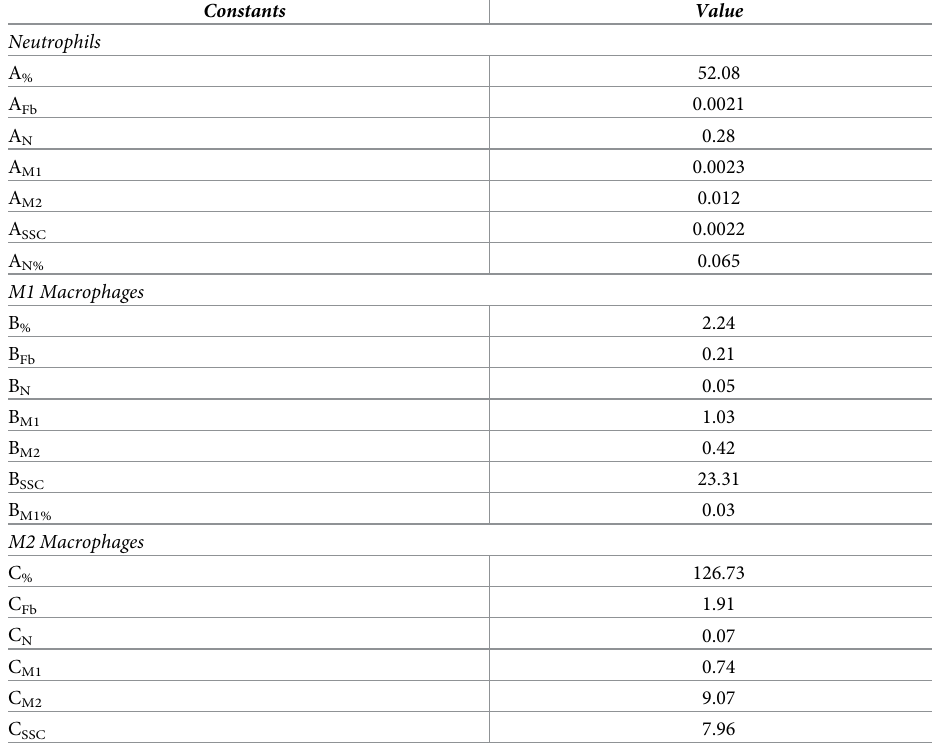
Table 3. Constants for inflammatory cell